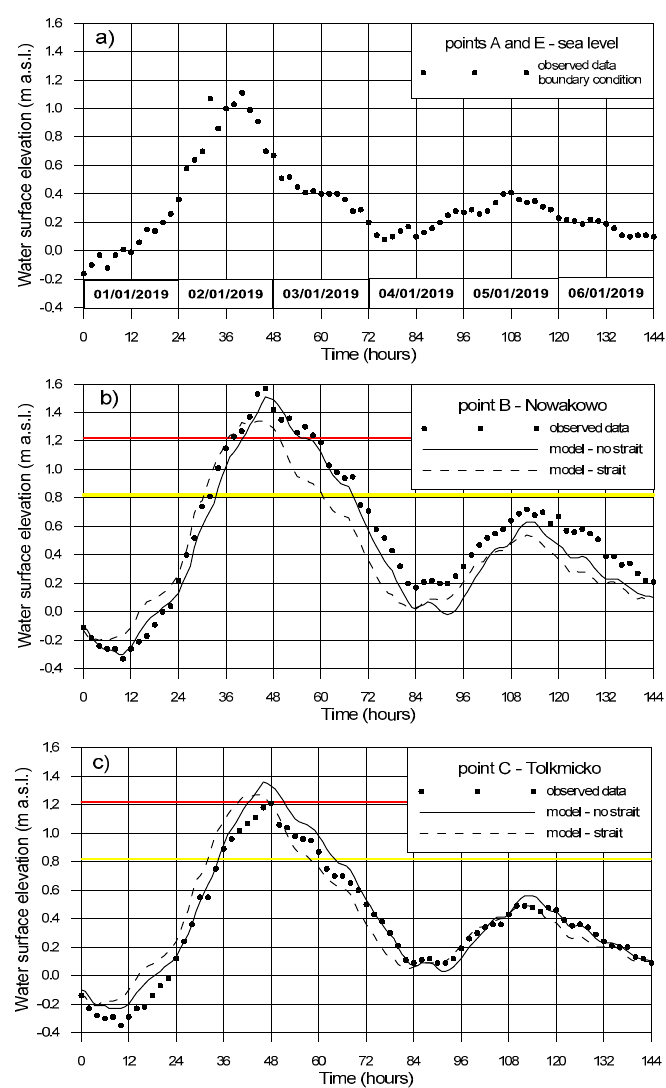
Figure 19. Observed and calculated water level at ( a ) points A and E, ( b ) point B and ( c ) point C (1 January–6 January 2019). The yellow and red lines represent the alarm and warning water surface levels, respectively.